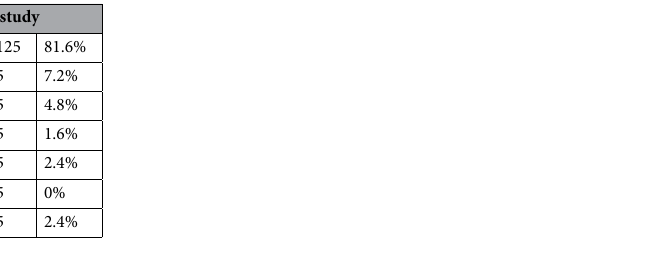
Table 6. Branch classification of hepatic